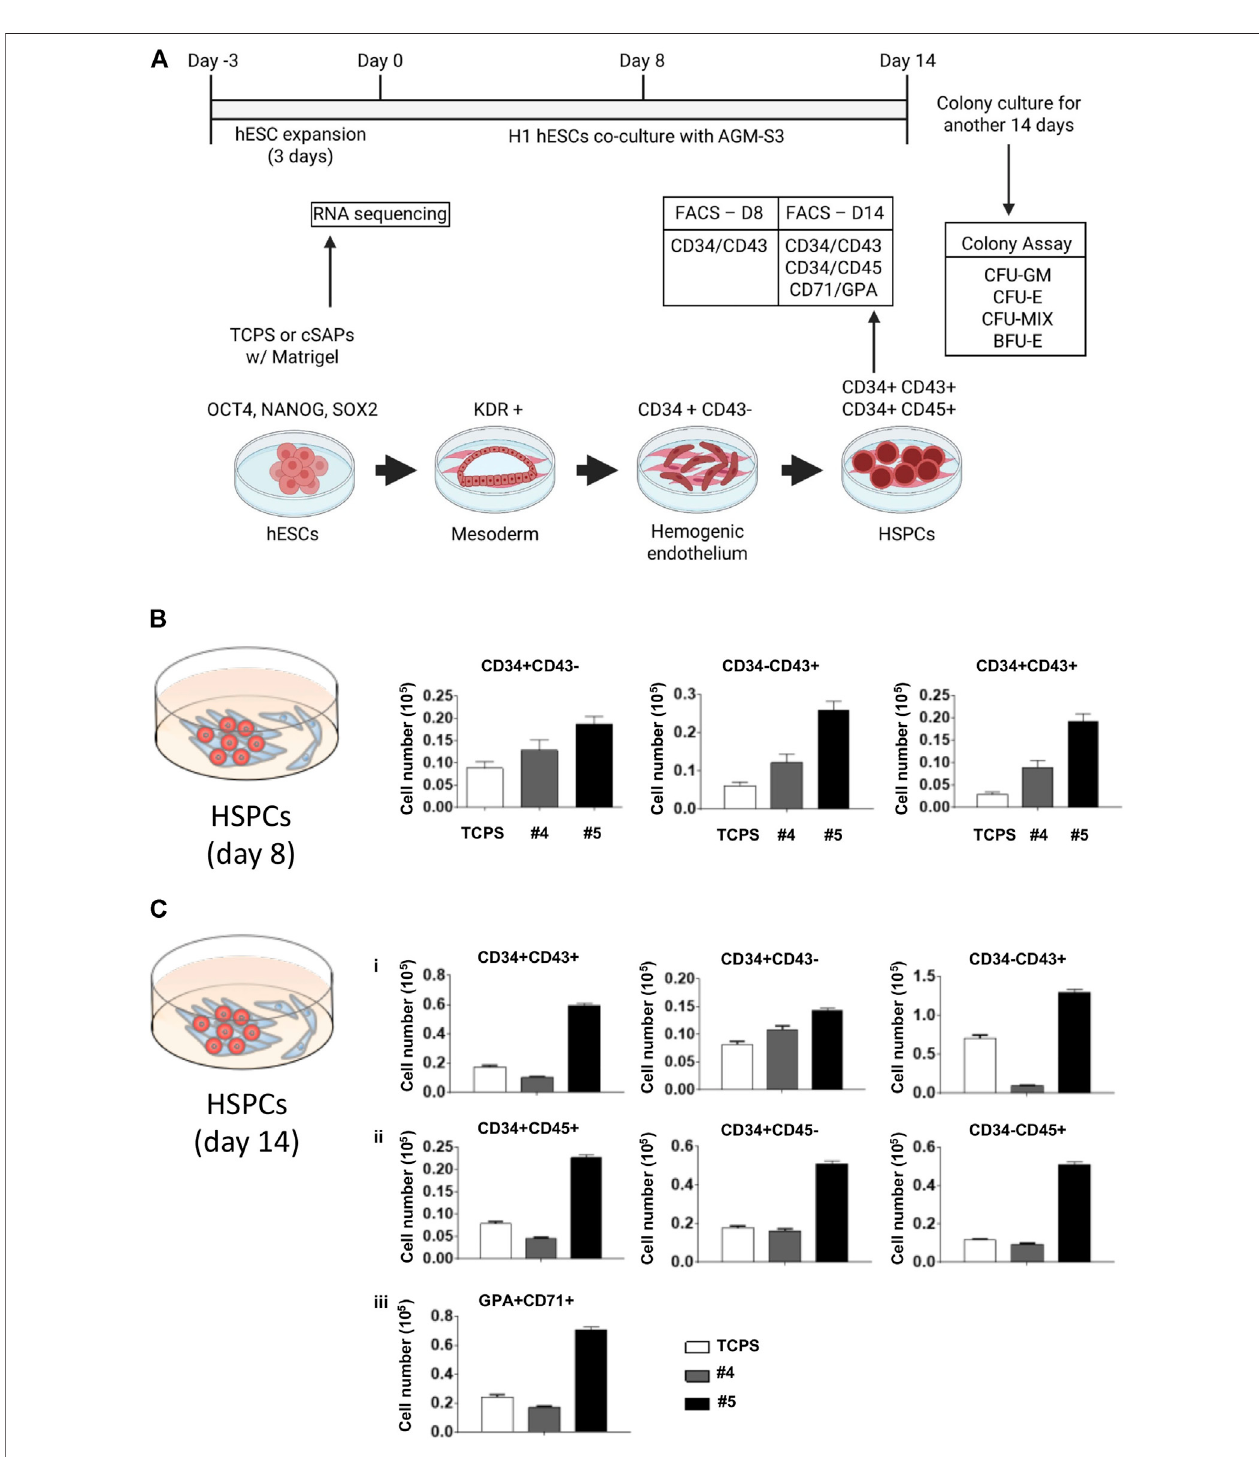
FIGURE 4 | Hemopoietic differentiation of cSAP-cultured hESCs. (A) Scheme of the H1 hESC expansion and hemopoietic differentiation. FACS analysis of the hemopoietic ef fi ciency of cSAP-cultured hESCs after (B) 8 days and (C) 14 days. Error bar (cid:1) SEM.